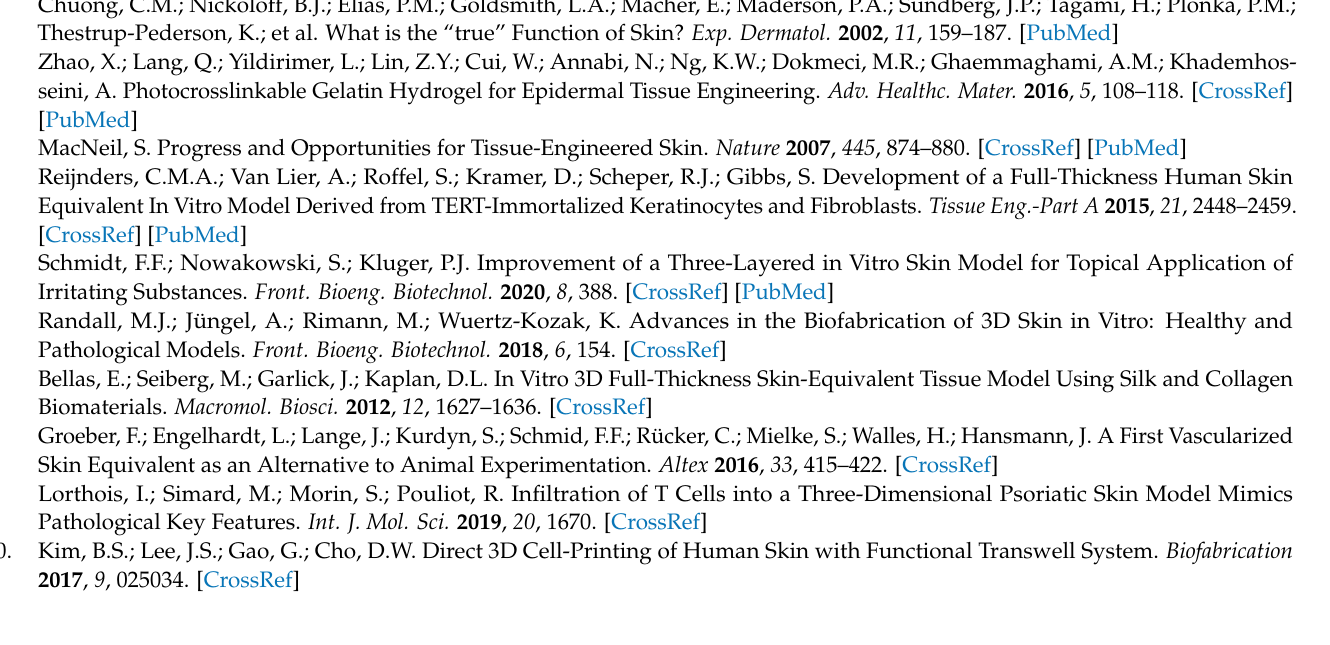
Figure S4: Epidermal stratification in HSE models generated in 3D printed